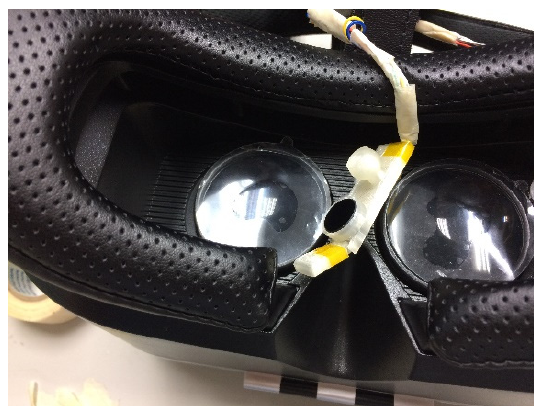
Figure 6. Comfortable space for the eye in the head-mounted device.